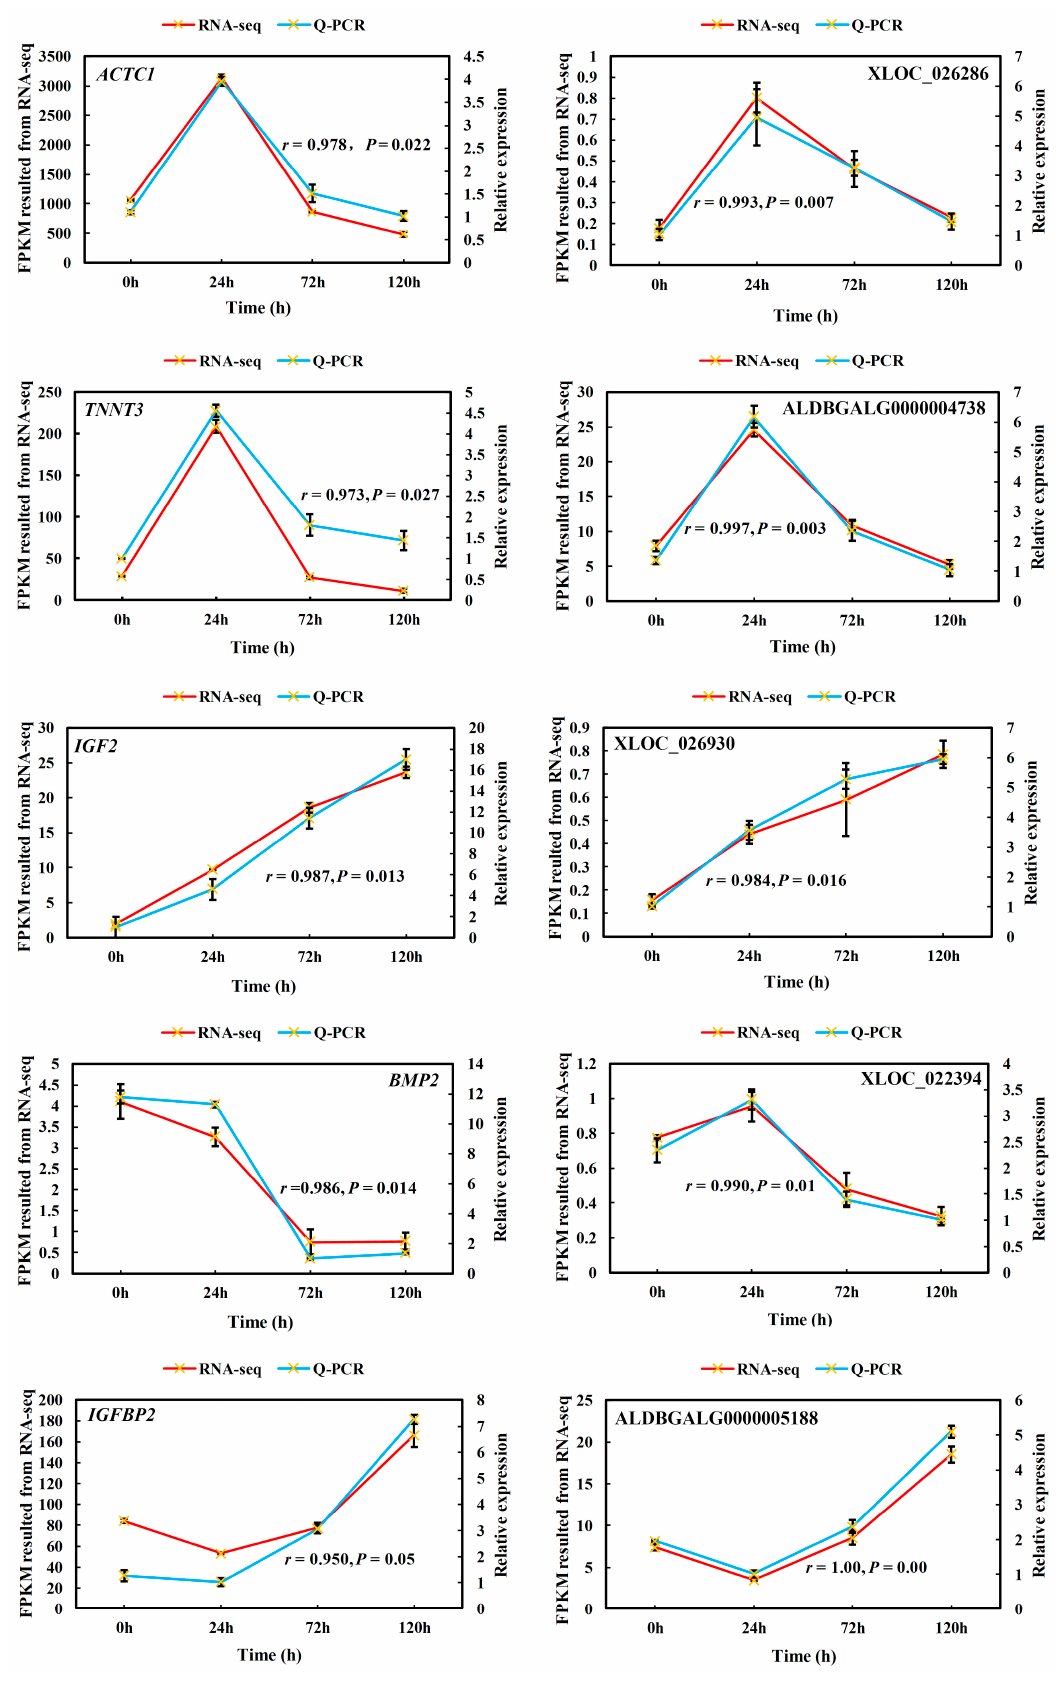
Figure 6. qPCR validation of differentially-expressed lncRNAs and their cis-target genes. FPKM: fragments per kilobase of exons per million mapped fragments.